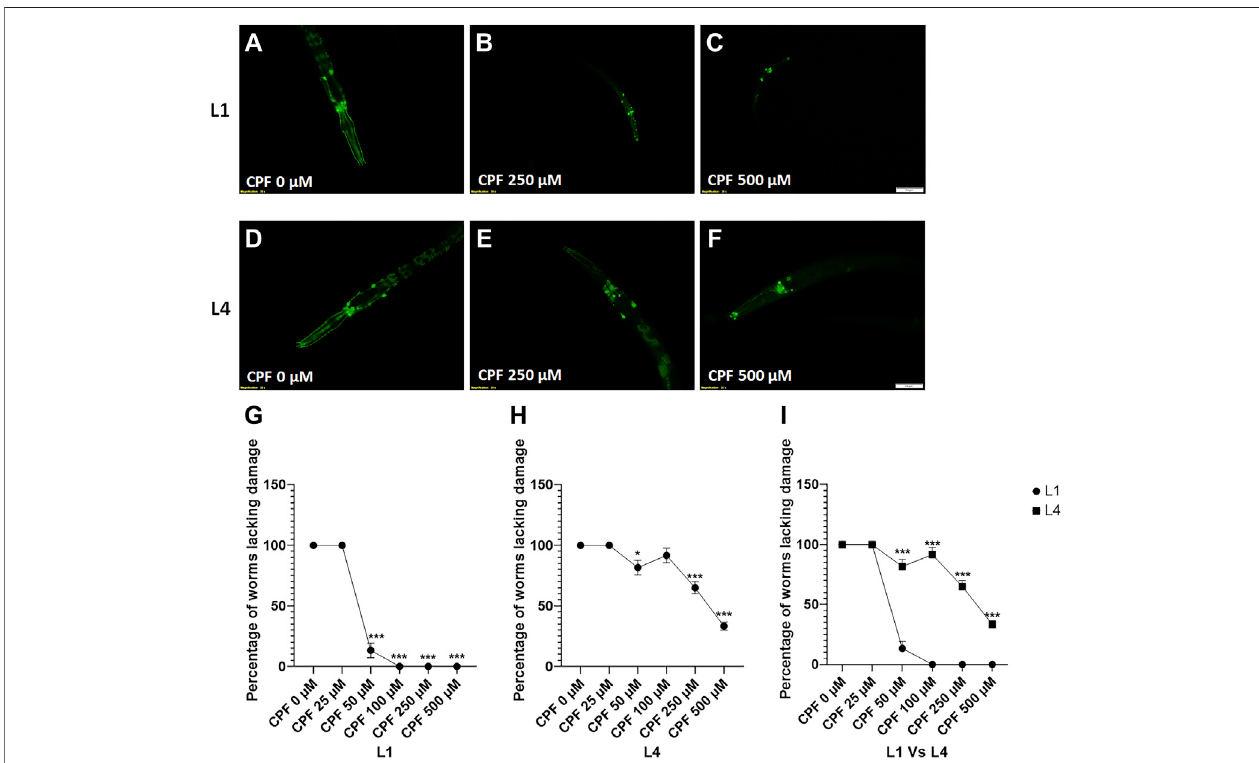
FIGURE5| Dopaminergicneurodegenerationanditsassessment: (A – C) BZ555wormsatL1stageexposedtodifferentconcentrationsofCPF(0 – 500 µM). (D – F) BZ555 worms at L4 stage exposed to different concentrations of CPF (0 – 500 µM). (G – I) Worms exhibiting neuronal damage, indicated by loss of neuron or dendrite breaksweremarkedasaffectedandgraphswereplottedforthepercentageofwormslackingneuronaldamageVsconcentrationforwormstreatedatL1 (G) andL4 (H) stages. (I) acomparison between theeffectson neuronaldamage for worms treated at L1 and L4 stages. A minimum of20 worms were analyzed per replicate.All experimentswereconductedinthreeindependentreplicatesDatawereanalyzedusingone-wayANOVAfollowedbyDunnett ’ sposthoctest.* p < 0.05,** p < 0.005,and *** p < 0.001( n =3).Scale barrepresents50 µm.Datawereanalyzed using one-way ANOVAfollowedbyDunnett ’ sposthoctest (AtoH)and two-way ANOVA followed by Sidak ’ s test for I. * p < 0.05, ** p < 0.005, and *** p < 0.001 ( n =